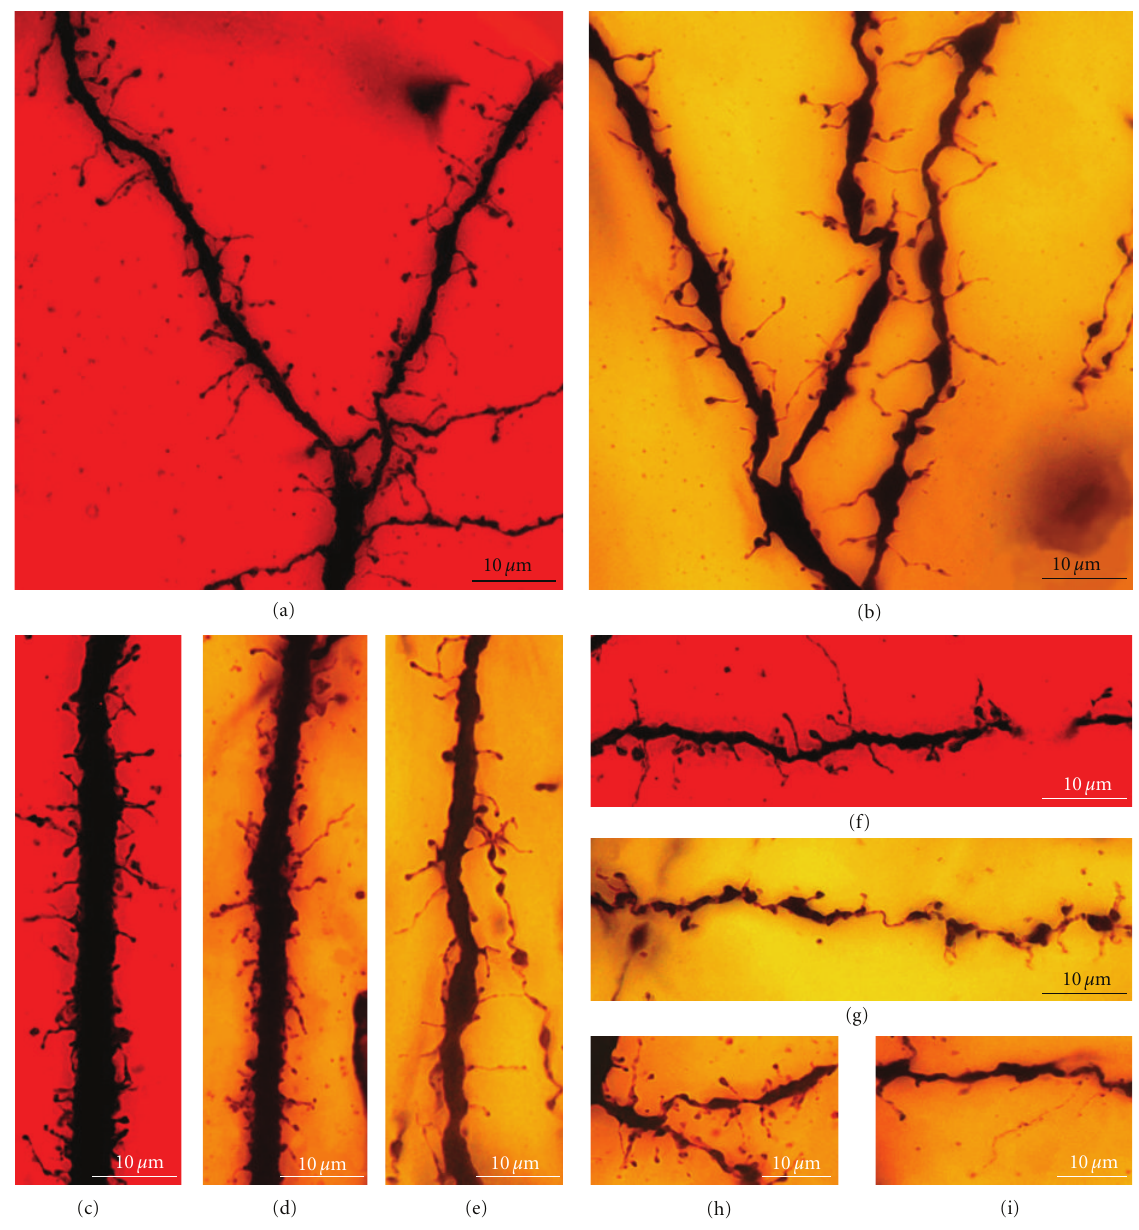
Figure 14: Extended focus images of filopodia, protospines and dendritic spines of the pyramidal cells from fetal and newborn animals, Cajal histological preparations, Golgi-method. (a) Apical tuft, pyramidal cell, visual cortex, fetus “almost newborn” according to the label of the Cajal histological preparation, cat. (b) Apical tuft, pyramidal cell, cerebral cortex, newborn rabbit. (c) Apical trunk, layer V pyramidal cell, visual cortex, fetus “almost newborn,” cat, bipolar phase. (d) Apical trunk, layer V pyramidal cell, newborn cat. (e) Apical trunk, layer V pyramidal cell, cerebral cortex, newborn rabbit. (f) Basilar dendrite, layer V pyramidal cell, cerebral cortex, fetus “almost newborn,” cat. (g) Basilar dendrite, layer V pyramidal cell, visual cortex, newborn rabbit. (h) Oblique dendrite, apical trunk, layer V pyramidal cell, cerebral cortex, newborn cat. (i) Oblique dendrite, apical trunk, layer V pyramidal cell, cerebral cortex, newborn human.